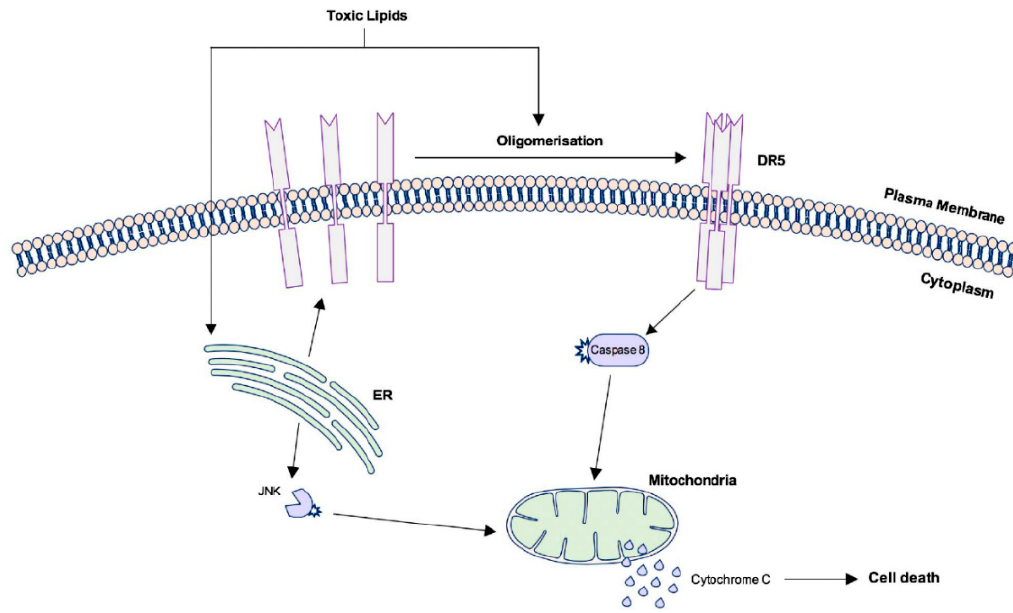
Figure 2. Signalling pathways leading to apoptotic cell death in lipotoxic hepatocytes. Palmitate and other toxic lipid metabolites trigger ligand-independent activation of TRAIL-R2 (DR5), leading to cell death via caspase 8 and egress of pro-apoptotic factors from the mitochondria. Toxic lipids also contribute to ER stress which may initiate the intrinsic pathway of apoptosis. ER: Endoplasmic reticulum; TRAIL-R2/DR5: TNF-related apoptosis-inducing ligand receptor 2/death receptor 5.